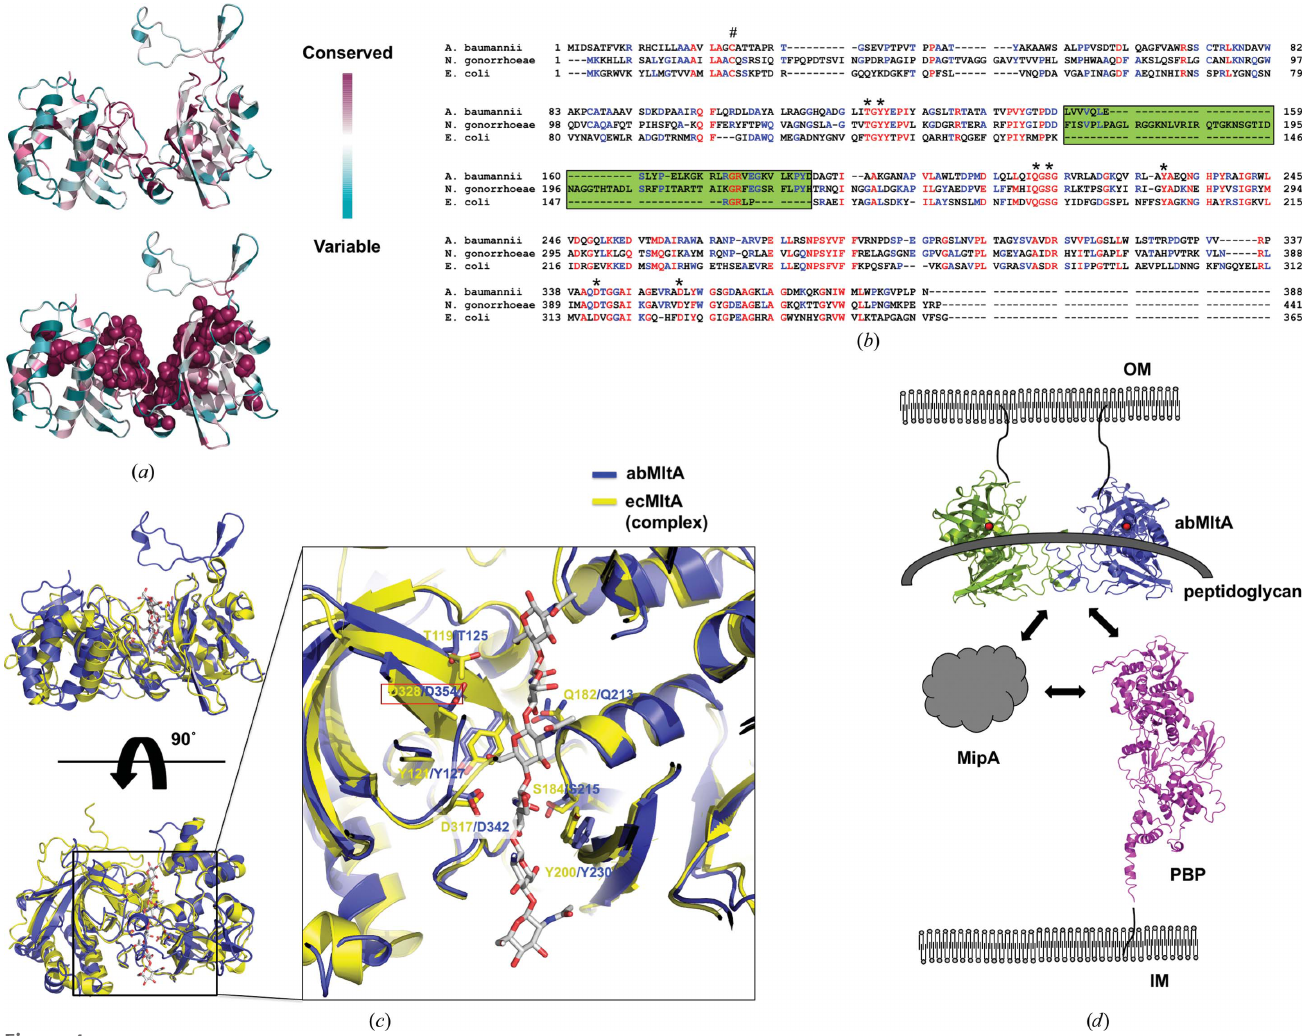
Figure 4 The tentative working mode of dimeric abMltA on the bacterial outer membrane. ( a ) Cartoon representation of abMltA colored according to the degree of amino-acid sequence conservation as analyzed by the ConSurf server. The side chains of completely conserved residues are shown with a ball-shaped model (lower panel) for better visualization. ( b ) Sequence alignment of MltA between different species. Mostly conserved and partially conserved residues are colored red and blue, respectively. The positions of the extra domain are highlighted by a green box. * indicates conserved residues that are involved in substrate binding. # indicates the conserved cysteine residue at the N-terminus of MltA, which is modified by lipid attachment for membrane anchoring. ( c ) Structural superposition of abMltA with the ecMltA–substrate complex. Seven residues that are involved in substrate recognition are labeled. The most critical residue directly involved in the cleavage of the substrate, Asp328 in ecMltA and Asp354 in abMltA, is highlighted using a red box. ( d ) Tentative working model of dimeric abMltA on the bacterial outer membrane. Red balls indicate the location of Asp354 (Asp328 in ecMltA), which is the most critical residue for the activity of MltA. OM and IM indicate the outer and inner membranes,